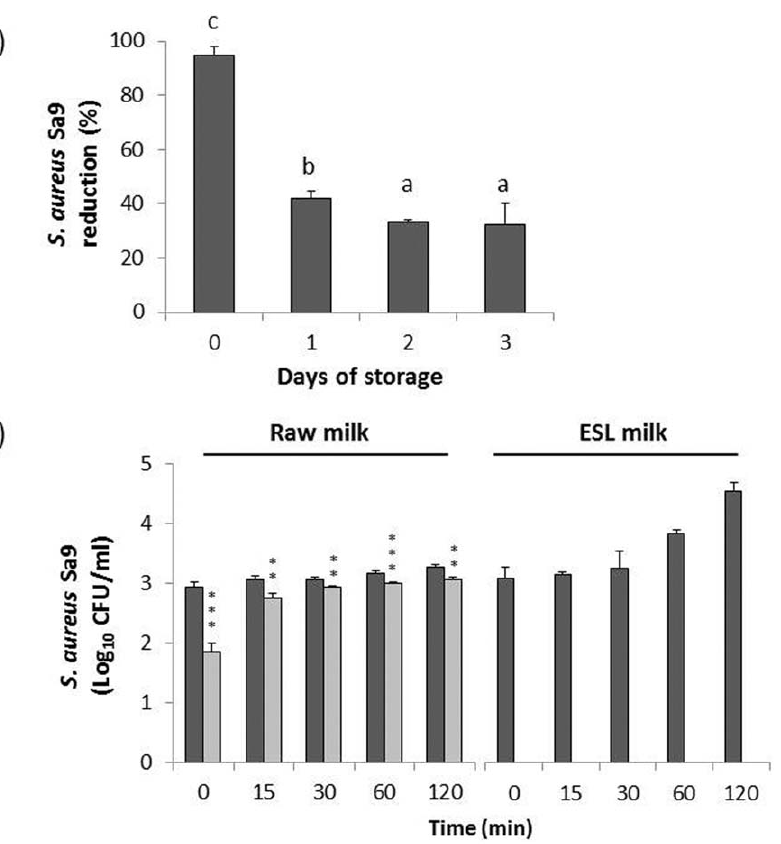
Figure 4. Cold storage stability and pasteurization resistance of CHAPSH3b in milk. A) 1.65 m M CHAPSH3b was stored in raw milk at 4 u C for 3 days. Samples were taken every day, inoculated with 10 3 CFU/ml of S. aureus Sa9 and incubated for 15 min at room temperature before plating. Non-cold storage protein was used as control. Cold storage stability was expressed as the percentage reduction of S. aureus Sa9 CFU/ml after CHAPSH3b addition. Values are the means 6 standard deviations of two independent experiments. Bars having different letters are significantly different ( P , 0.05). B) 1.97 m M CHAPSH3b was pasteurized at 72 u C for 15 s in raw milk (left) and commercial pasteurized milk (right). Samples were inoculated with 10 3 CFU/ml and incubated for 0 , 15, 30, 60 and 120 min at room temperature before plating. S. aureus inoculated cultures without lytic protein addition were used as control (dark grey bars). Light grey bars indicate S. aureus Sa9 + CHAPSH3b. Data from pasteurized samples with CHAPSH3b activity was expressed as log CFU/ml. Values are the means 6 standard deviations of two independent experiments. Bars having asterisks are significantly different from the control (** P , 0.01; *** P , 0.001).